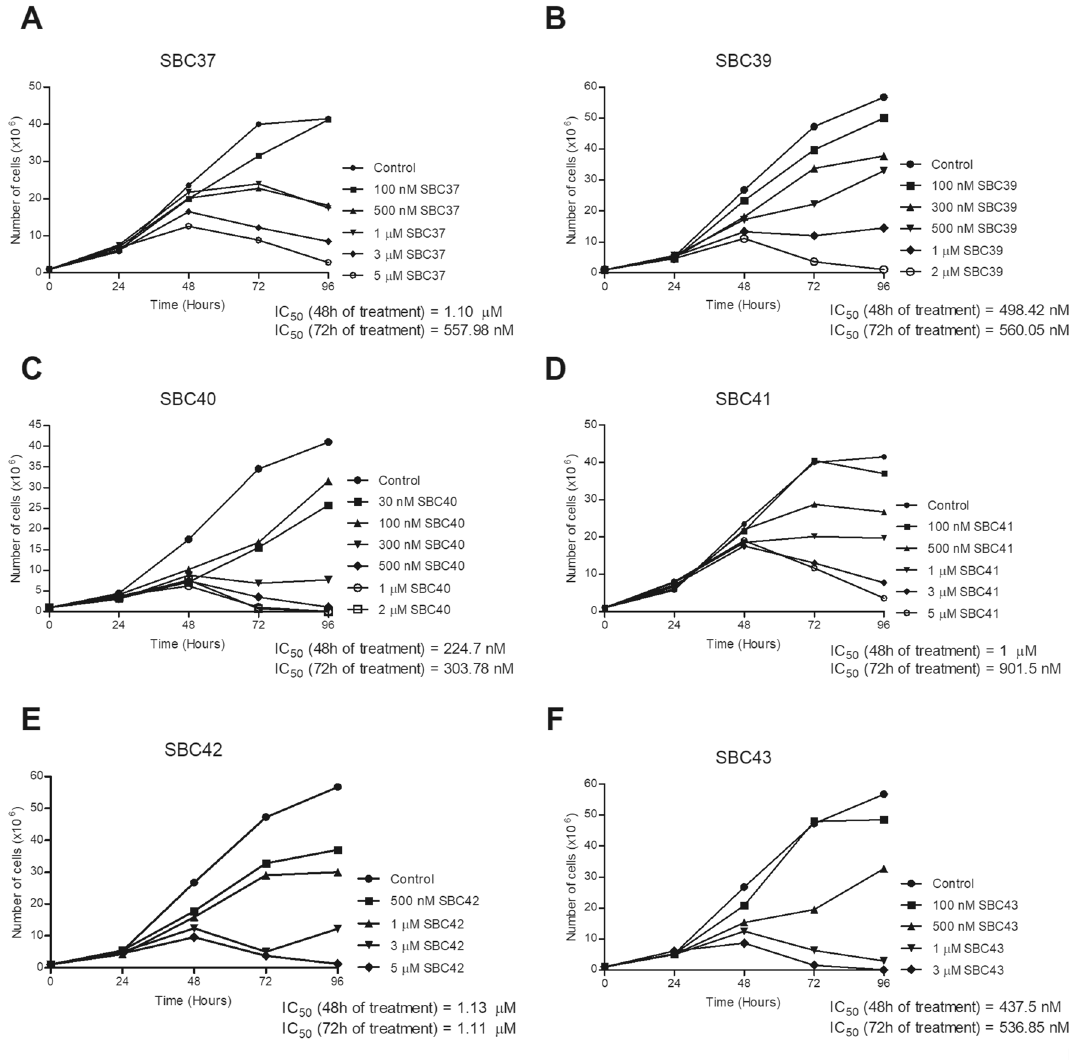
Figure 3. Evaluation of antiproliferative effects of SBCs on Leishmania amazonensis promastigotes. Parasites were treated with SBCs for 72 h to evaluate the parasite growth. The inhibitors were added at different concentrations after 24 h of growth. The most potent inhibitors were SBC 37 ( A ), SBC 39 ( B ), SBC 40 ( C ), and SBC 43 ( F ) with IC 50 of 557 nM, 560.05 nM, 303.78 nM, and 536.85 nM, respectively, after 72 h of